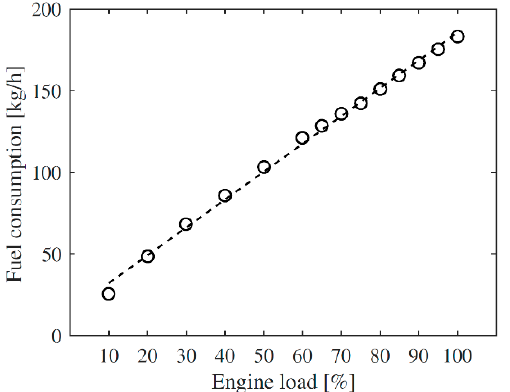
Figure 2. Linearized engine fuel consumption as a function of the engine load. Example for the engine Wärtsilä 6L20DF. Dots: engine data; dashed line: linear approximation.